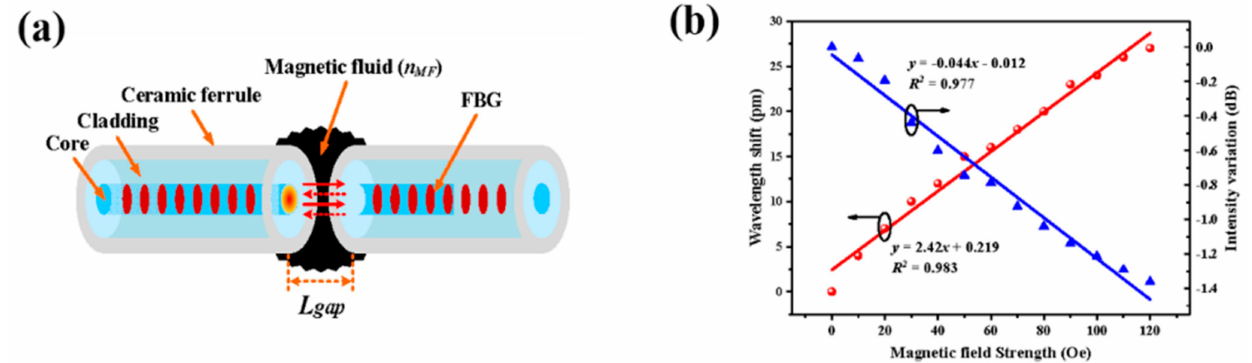
Figure 15. ( a ) Schematic diagram of the proposed magnetic field sensor. ( b ) Wavelength shift and intensity variation of the transmission peak against magnetic field strength. Adapted with permission from ref. [99]. © [2022]